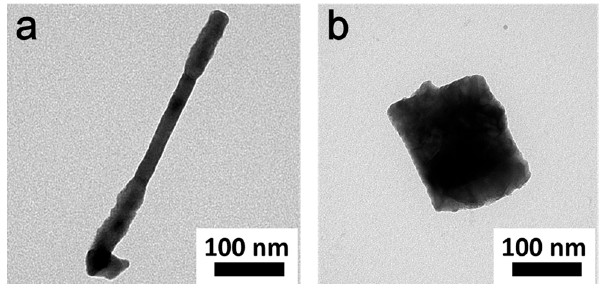
Figure 10. TEM of converting ( a ) CuTe nanorods and ( b ) CuTe nanocubes into CuInTe 2 . The reaction time was 5 min.